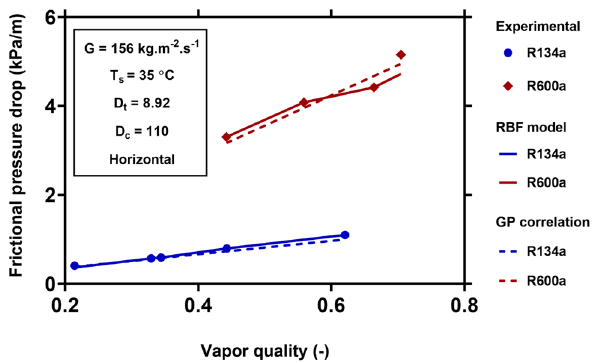
Figure 11. Effect of working fluids on the variation of the two-phase FPD versus vapor quality. Comparisons of predictions of GP correlation (Eq. (20)) and RBF model with the corresponding experimental values 24,67 .